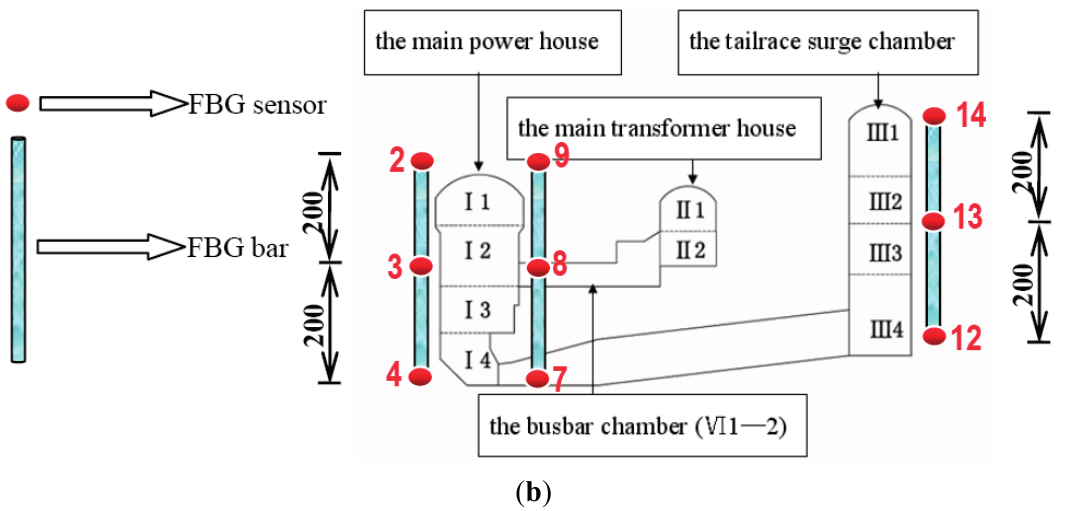
Figure 8. Layout of the FBG sensing bars (Unit: mm). ( a ) A top view; ( b ) A front